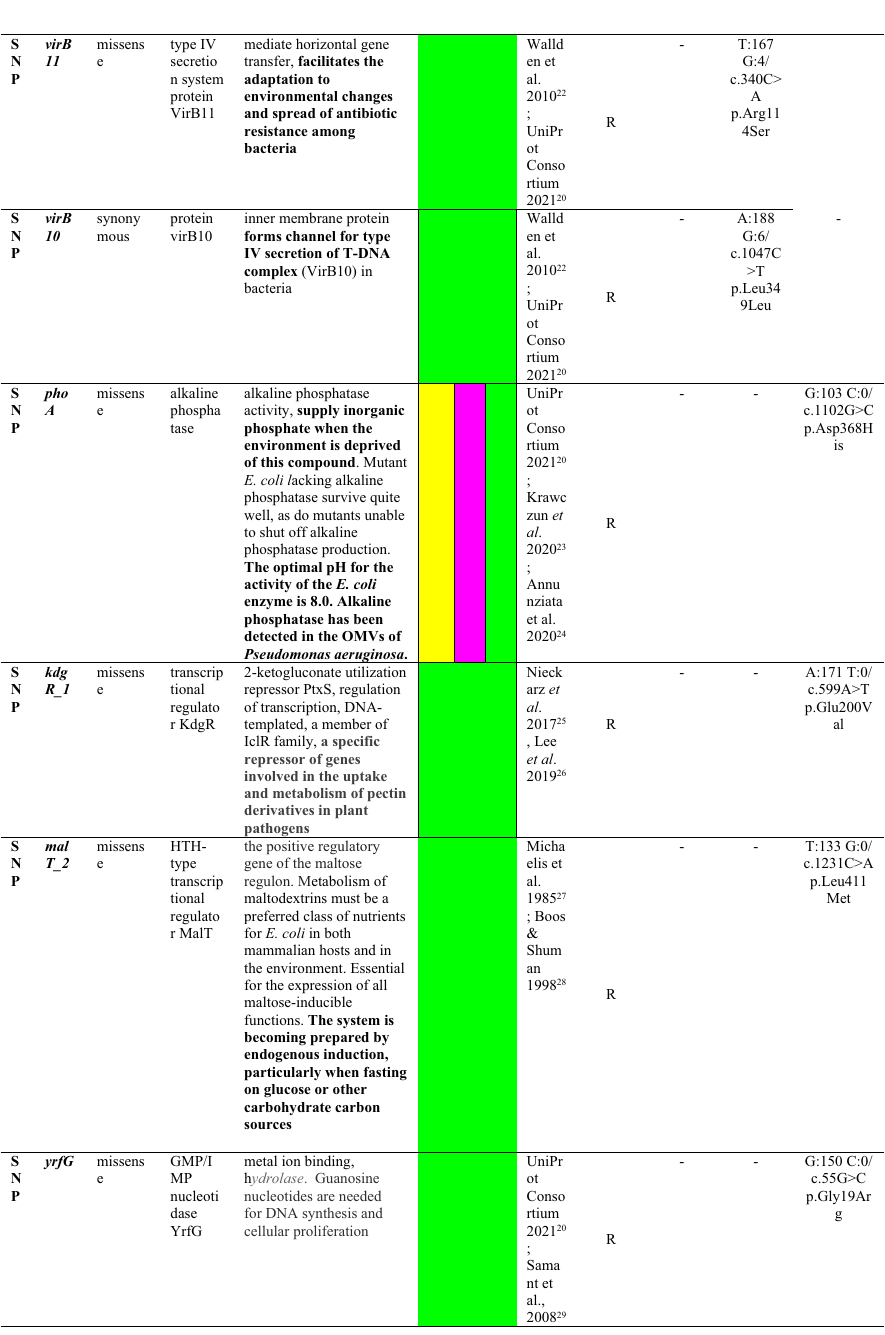
Table 2. Clinical, epidemiological and genetic characteristics of ST437 polymyxin-resistant carbapenemase- producing K. pneumoniae strains and SNP variations possibly related to specific stages of bacterial infection. Case number and respective strain in order of detection. a Rectal swab negative for carbapenem-resistant Enterobacteriaceae (CRE) on 12/15/2014. b Not discriminating mutations that identify hypothetical or undefined proteins. c Specific stages of bacterial infection in which the mutated gene could be related, according to the referral literature, as: adherence and mucosal colonization (yellow), invasion and systemic infection (pink) and resistance, survival or proliferation (green). d Same mutation is highlighted in gray color in Table cells. OMVs outer membrane vesicles, PCR-Kp polymyxin-carbapenem-resistant K.